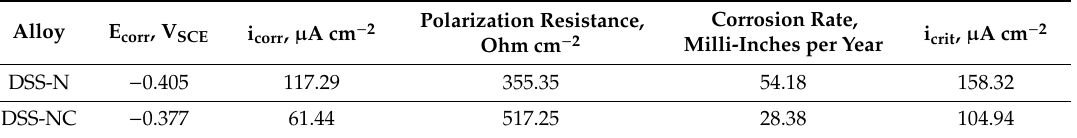
Figure 10. Resistance to general corrosion of the DSSs: ( a ) Linear potentiodynamic polarization curves of the DSS-N and DSS-NC measured in a 0.2 M HCl solution at 25 ◦ C with a potential sweep rate of 2 mV s − 1 , and ( b ) the enlarged polarization curves showing active–passive transition behavior. ( c ) The average and standard deviation values (scatter band) of the corrosion rate (i corr ) and critical anodic current density (i crit ), which were obtained from five repeated polarization tests. Table 4. The corrosion characteristics of the DSS-N and DSS-NC measured through polarization tests in a 0.2 M HCl at 25 °C (Figure 10).